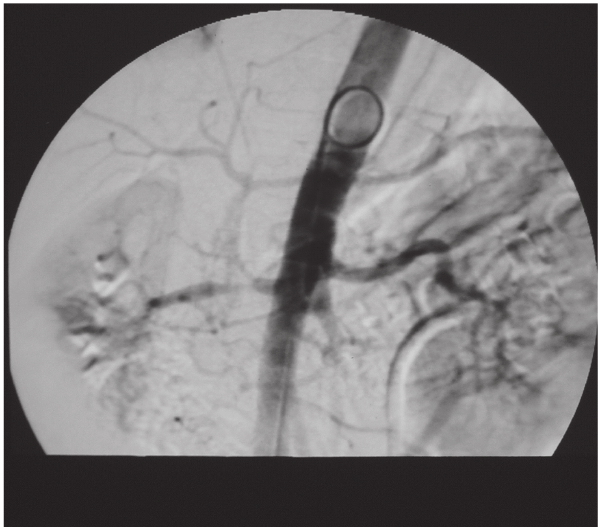
Figure 2 - Renal arteriography showing right renal artery stenosis (arrow).